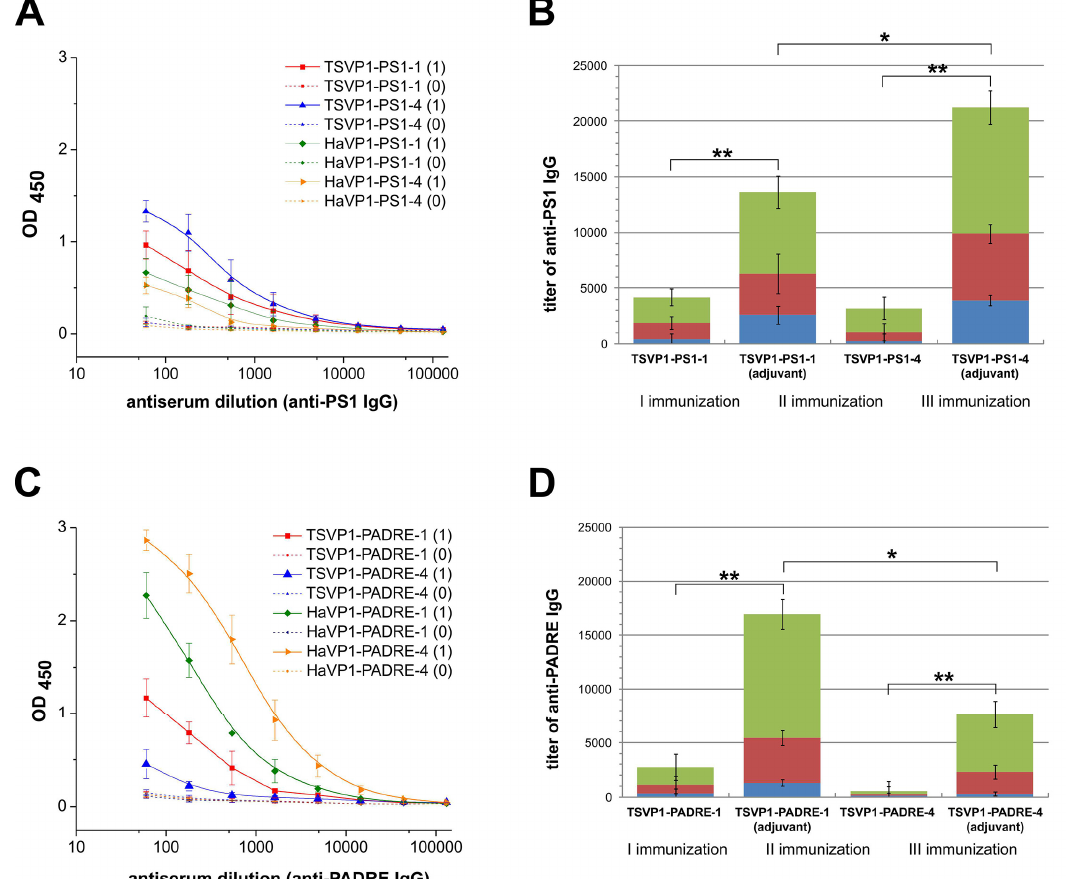
Figure 6. Antibody responses against the PS1 peptide ( A , B ) and PADRE peptide ( C , D ) in in BALB/c mice (n = 3 per group) immunized with chimeric VLPs (TSVP1-PS1-1, BALB/c mice (n = 3 per group) immunized with chimeric VLPs (TSVP1-PS1-1, TSVP1-PS1-4, TSVP1-PADRE-1, TSVP1-PADRE-4) as determined by an indirect TSVP1-PS1-4, TSVP1-PADRE-1, TSVP1-PADRE-4) as determined by an indirect ELISA.